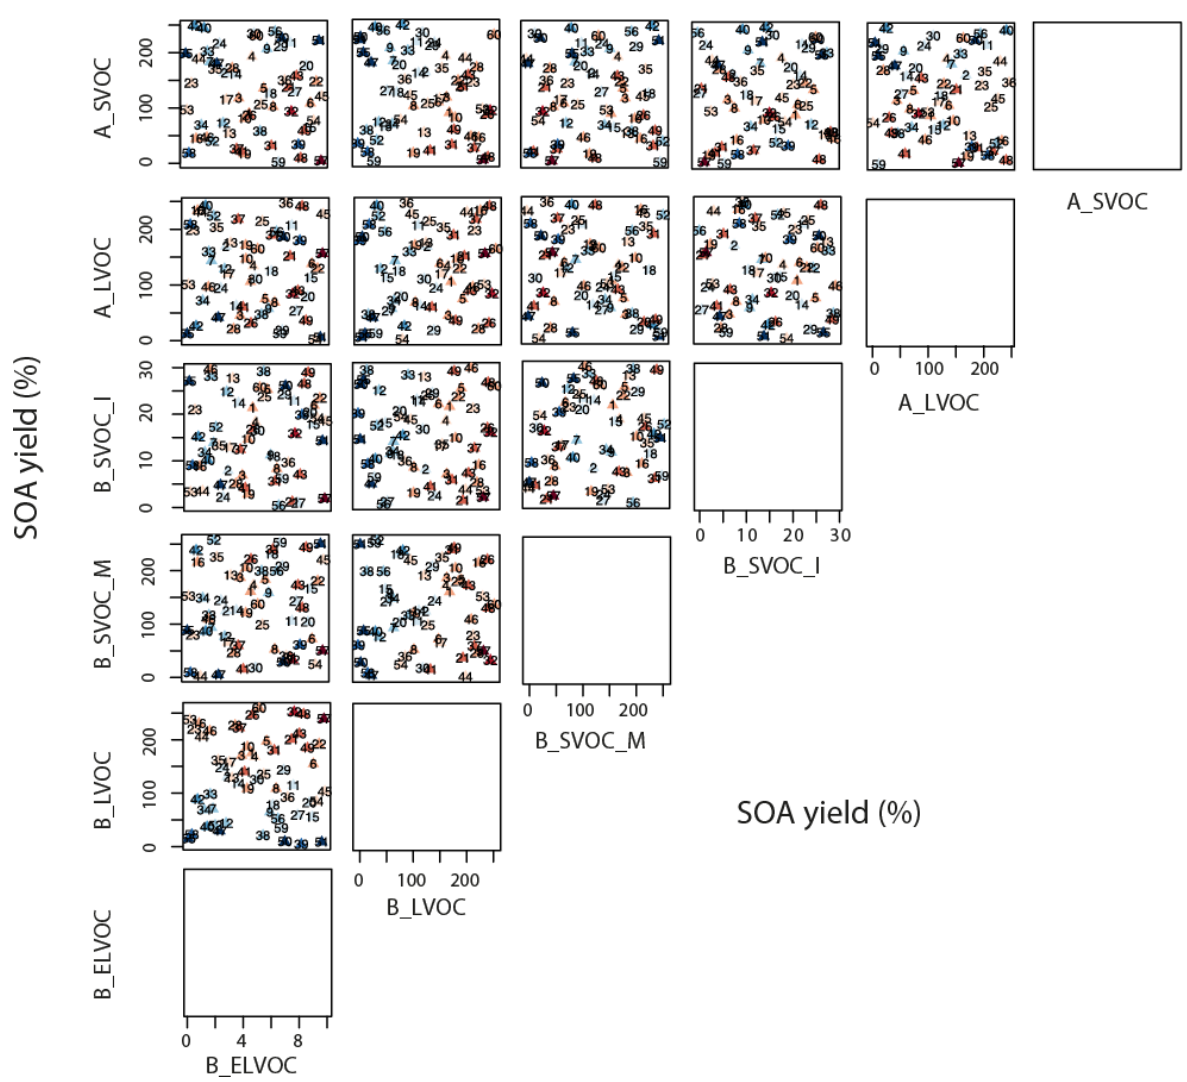
Figure A4. Taylor skill score for model simulations against N50 observations across the 6-D parameter space. The x and y axes for a subplot show the total range of reaction yields (%) over which of the two parameters (as indicated by the plot labels at the top and right for each subplot respectively) is perturbed in the ensemble. Each triangle in a subplot represents a simulation (labelled 1–60) and the color of the triangle indicates its Taylor skill score for N50. Darker shades of blue indicate low/poor Taylor skill score and darker shades of red represent high/good Taylor skill score. Note the axis for B_ELVOC shows the scaling factor for B_ELVOC yields. Axes for the rest show the corresponding ox-VOC